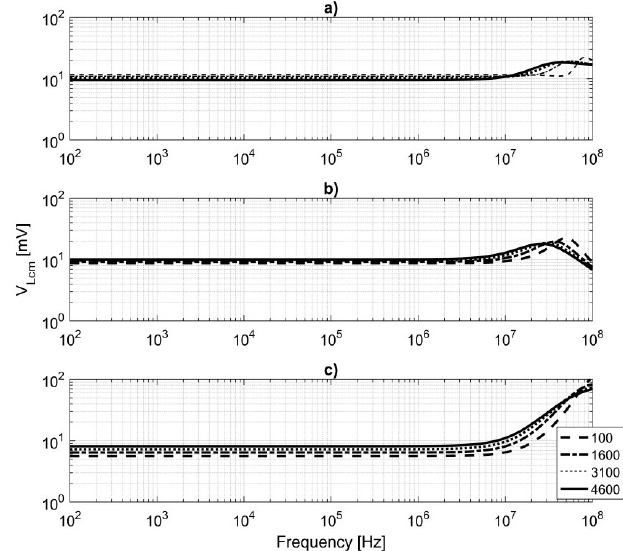
Fig.21: Simulated common mode load voltage ( V Lcm ) of the proposed group, with unmatched (± 1%) control resistors ( r and r x ), for four different loads. The label shows the values of the loads in Ω. a) QUAD b) DIF_C c)